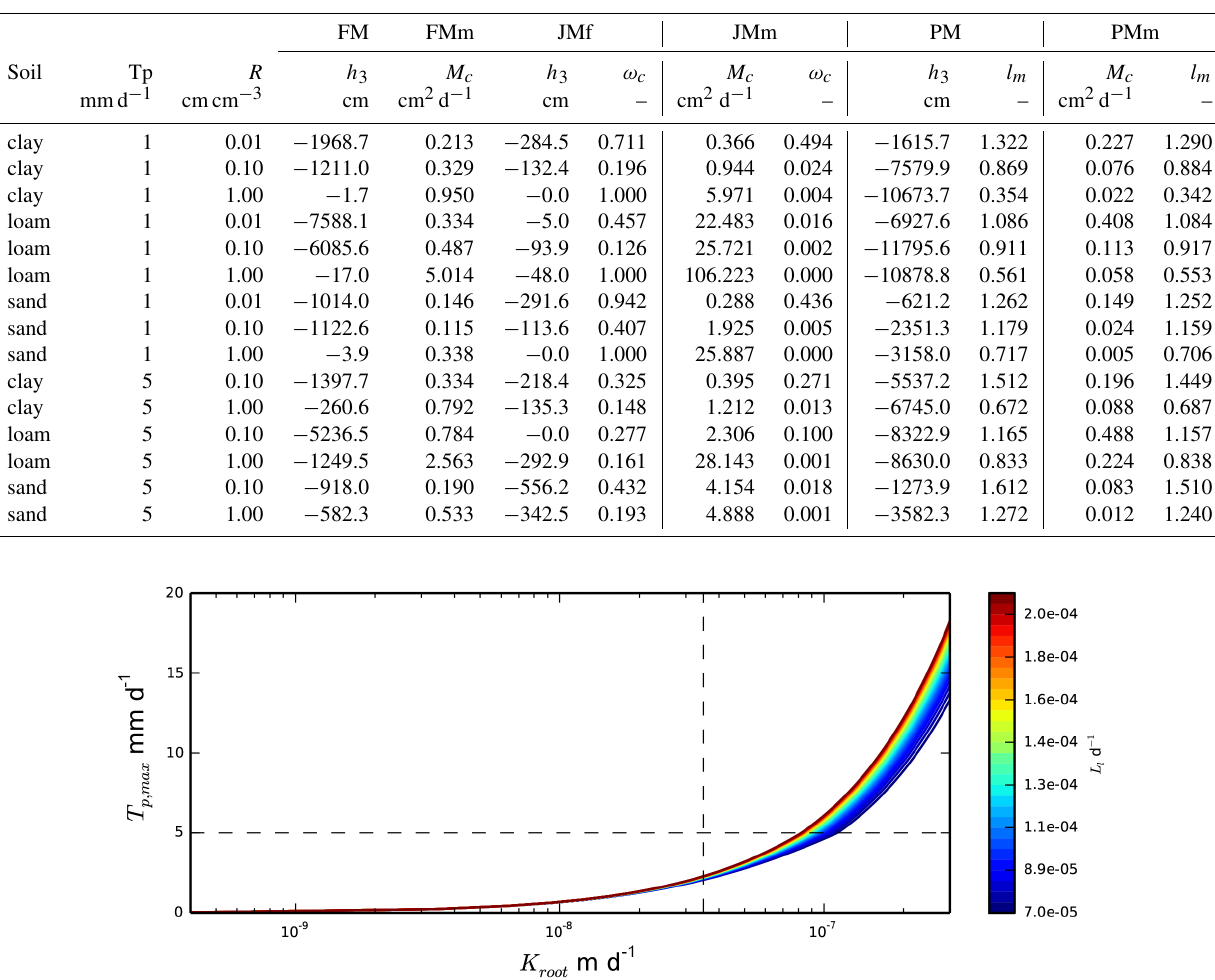
Figure 5. Maximum possible transpiration T p, max as a function of root hydraulic conductivity K root for some values of the overall con- ductance over the root-to-leaf pathway L l computed by the De Jong van Lier et al. (2013) model for a rooting depth of 0.5m, low root length density, and a constant soil pressure head over depth equal to − 1m for sandy soil. The dashed vertical line highlights the value of K root = 3.5 · 10 − 8 md − 1 that was used in our simulations. The horizontal dashed line highlights the value of potential